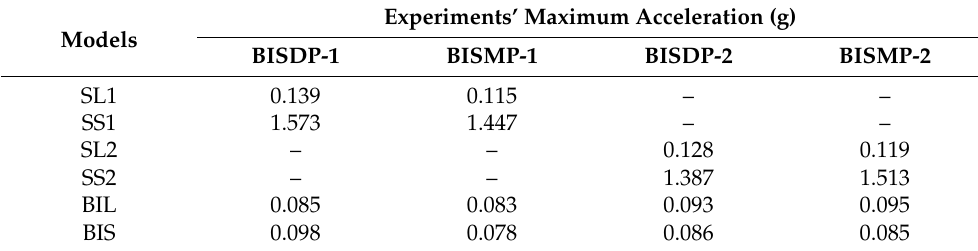
Figure 8. Responses of DP and MP in stiffer base-isolated models. Table 8. Maximum response in stiffer models.